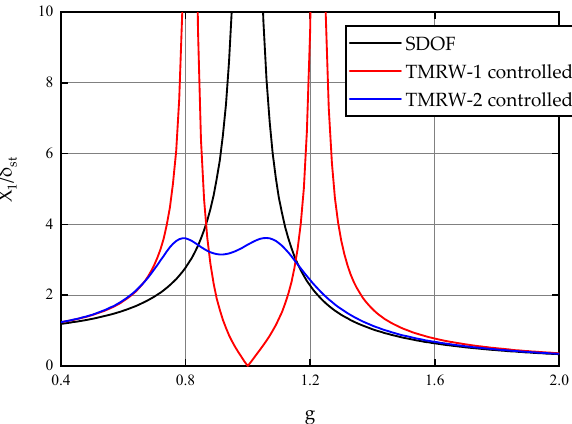
Figure 4. Comparison of TMRW-1 and TMRW-2 controlled dynamic amplification.